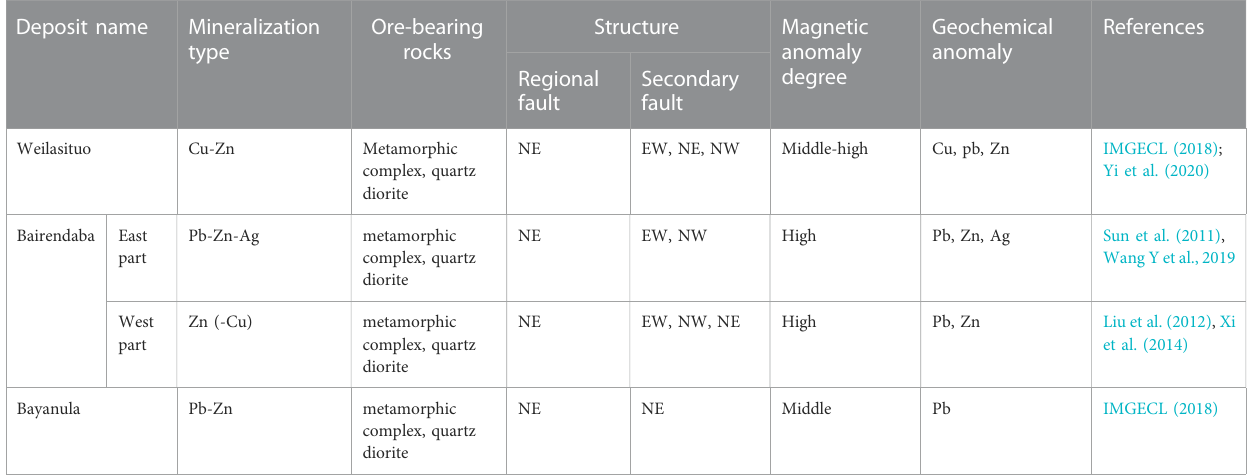
TABLE 3 The deposit geology of typical deposits in the